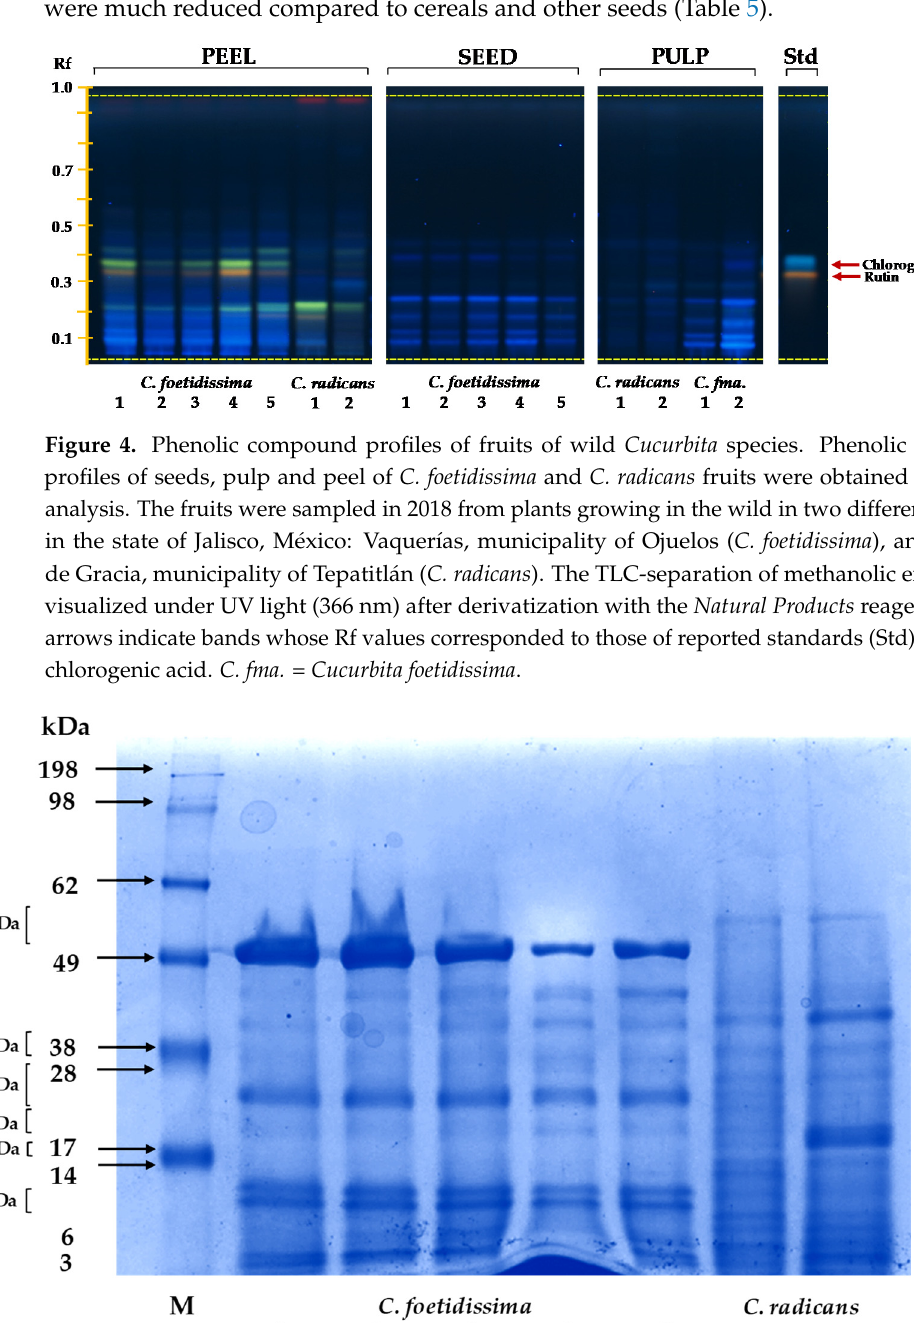
Figure 5. Seed protein profiles of wild Cucurbita species. The SDS-PAGE separation of seed proteins from C. foetidissima and C. radicans fruits is shown. The fruits were sampled in 2018 from plants growing in the wild in two different locations in the state of Jalisco, M é xico: Vaquer í as, municipality of Ojuelos ( C. foetidissima ), and San Jos é de Gracia, municipality of Tepatitl á n ( C. radicans ). The protein bands were visualized after incubation in a Coomasie Blue stain solution. The arrows indicate bands whose Rf values corresponded to seed proteins described in related Cucurbita species [45–48]. M = molecular mass protein markers, in kilo Daltons (kDA).